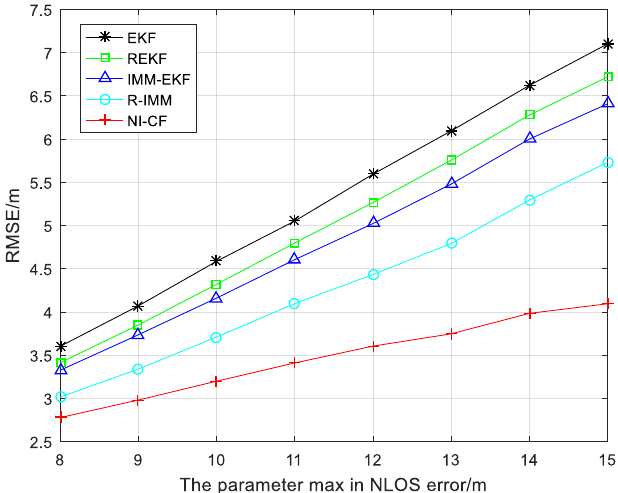
Figure 8. The RMSE versus the parameter max in NLOS error. Table 5. The average RMSE values of different algorithms.